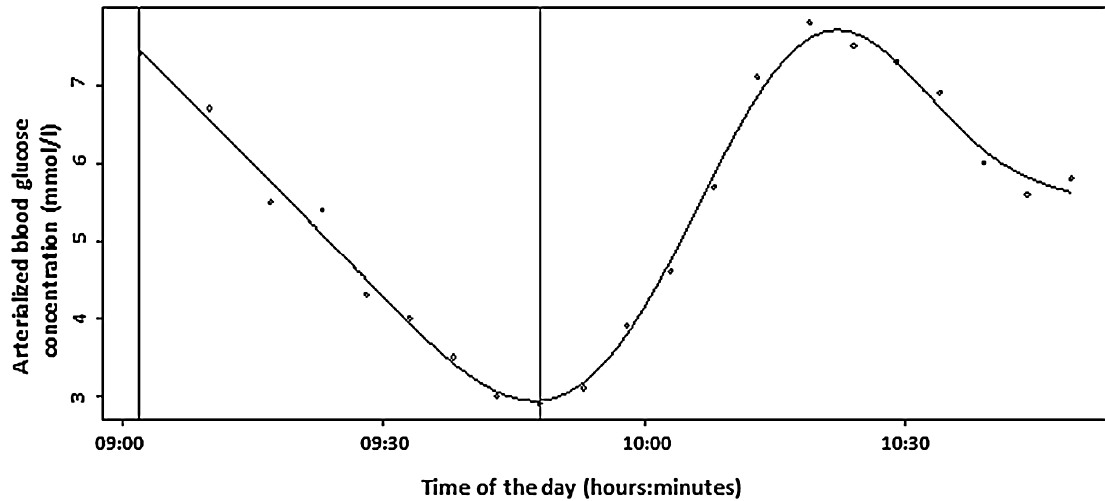
Figure 1. The curve of glucose concentration values during the study (Patient 1). The first vertical line represents the beginning of the exercise, and the second one represents the end of exercise and ingestion of 20 g of glucose.